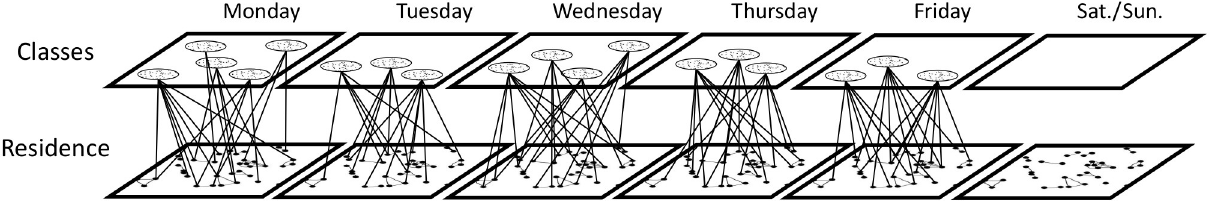
Fig 1. Example of student networks over time. Students (dots) in the each class (ovals in upper boxes) form complete networks. Students in residences form relatively sparse networks (below). Infected students carry their infections from day to day, even if not in a class on certain days.